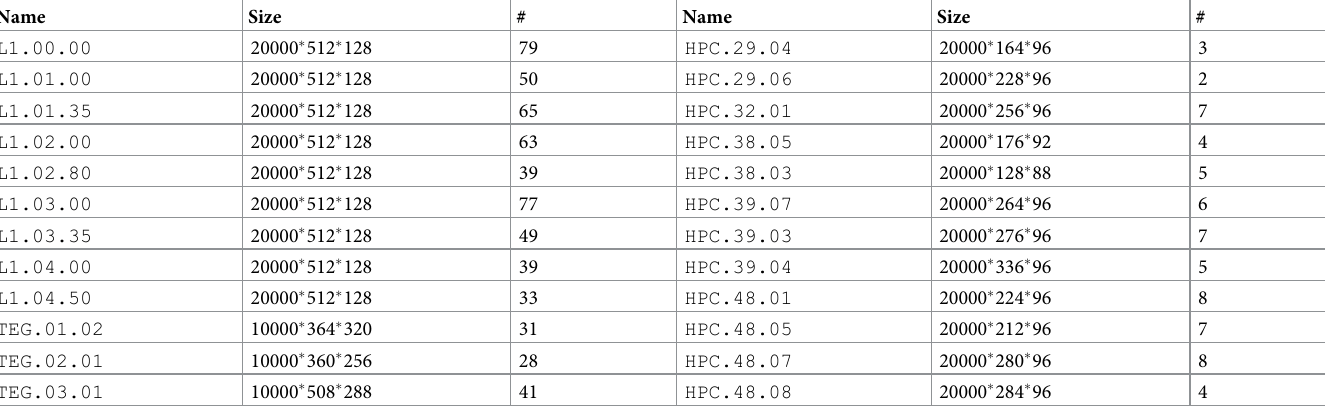
Table 2. All annotated datasets for segmentation of VolPy . For each dataset the name, size of datasets and number of labeled neurons are